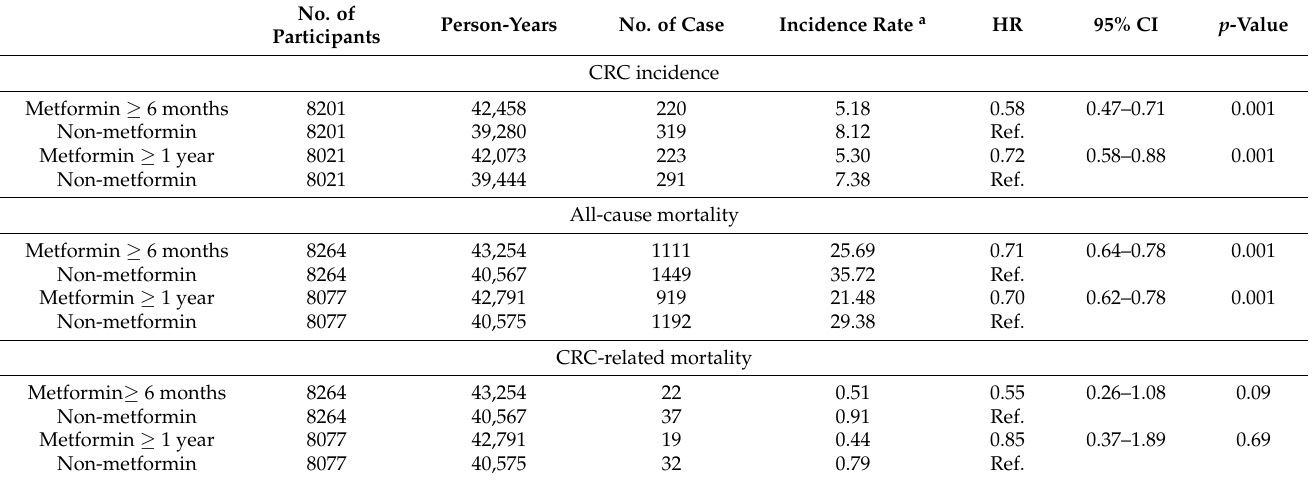
Table 2. Incidence of colorectal cancer, all-cause mortality, and colorectal cancer-related mortality in metformin